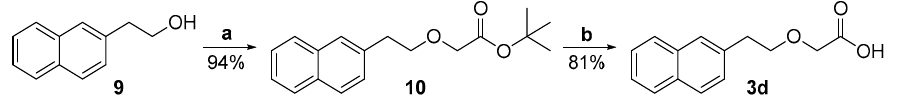
Figure 6. Synthesis of α -ketobenzoxazoles 17a,c,d and α -ketobenzimidazoles 17b,e . (a) (i) NaHSO 3 , CH 2 Cl 2 ; (ii) KCN, H 2 O; (b) (i) CH 3 COCl, CHCl 3 /absolute EtOH; (ii) 2-aminophenol or 2-phenylene- diamine, absolute EtOH; (c) Dess–Martin periodinane, CH 2 Cl 2 . The synthesis of keto-1,2,4-oxadiazoles was accomplished following a previously published procedure, as depicted in Figure 7. Amidoxime 19 was synthesized from alde- hyde 13a through the corresponding O- tert -bytyldimethylsilyl cyanide 18 [21]. It was then